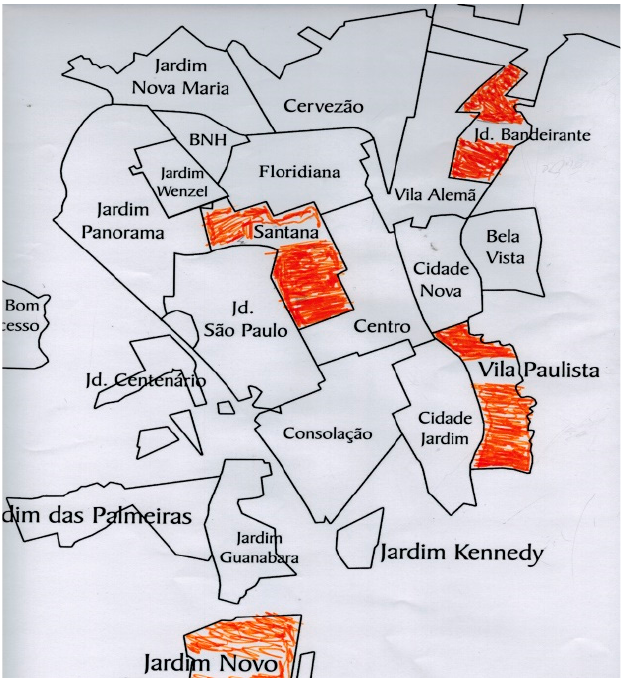
Figure 2. Idem Figure 1.